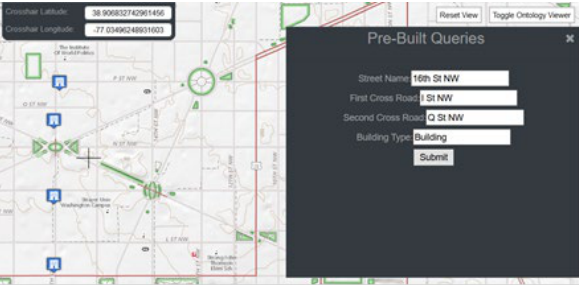
Figure 6 . Pre-Built query finding buildings depicted in blue between two road